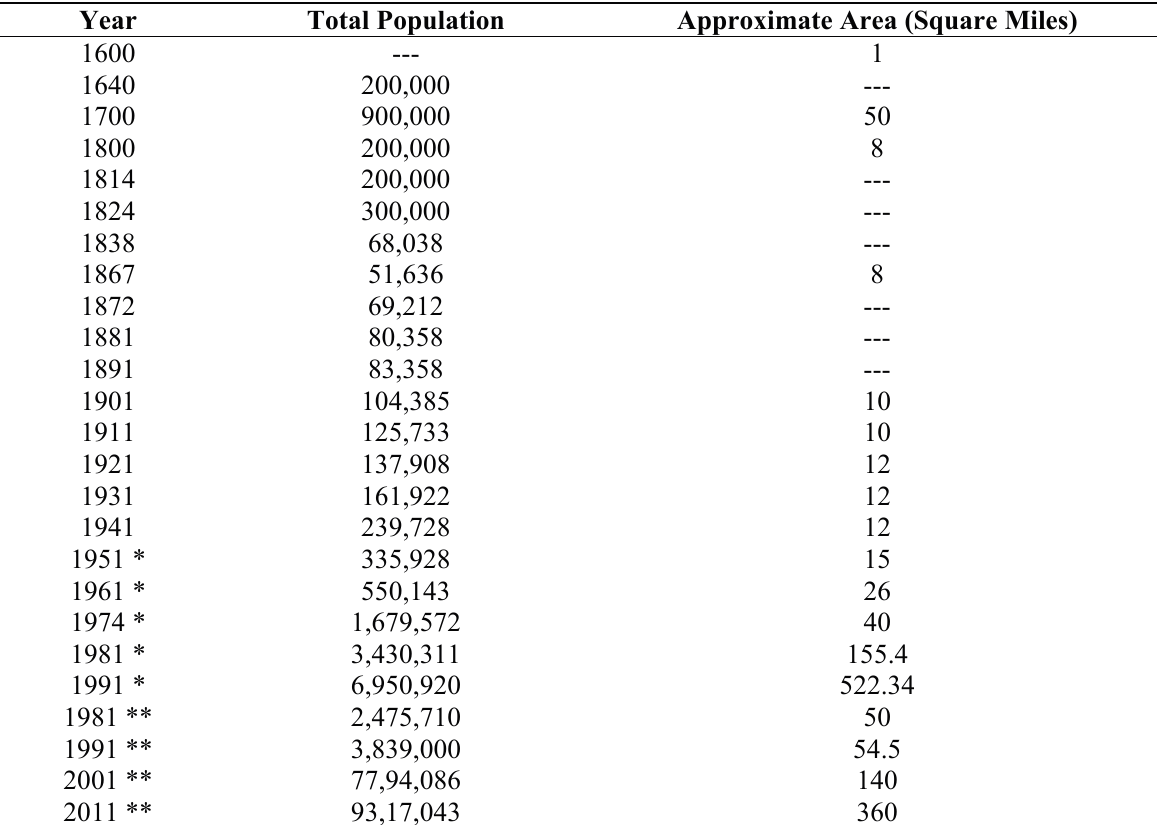
Table A1. Historical growth of Dhaka City in population and